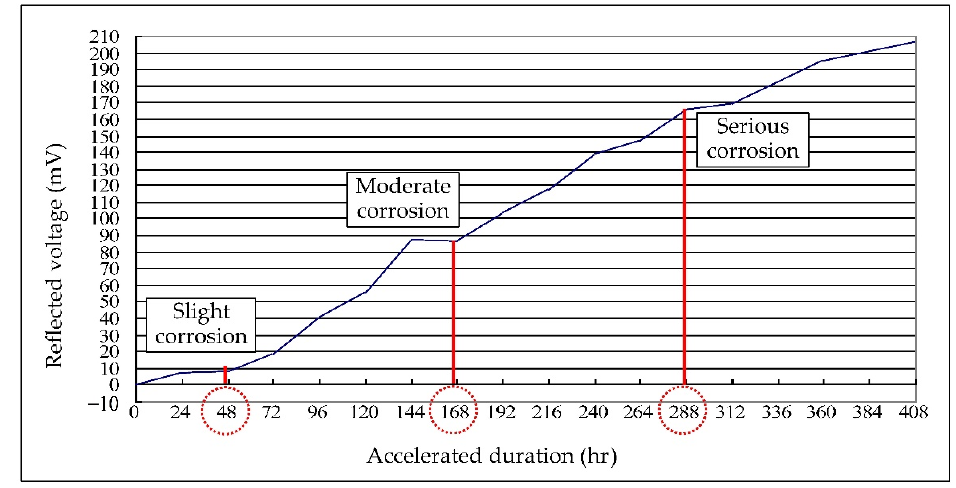
Figure 15. Reflected Voltage of 7 cm Protective